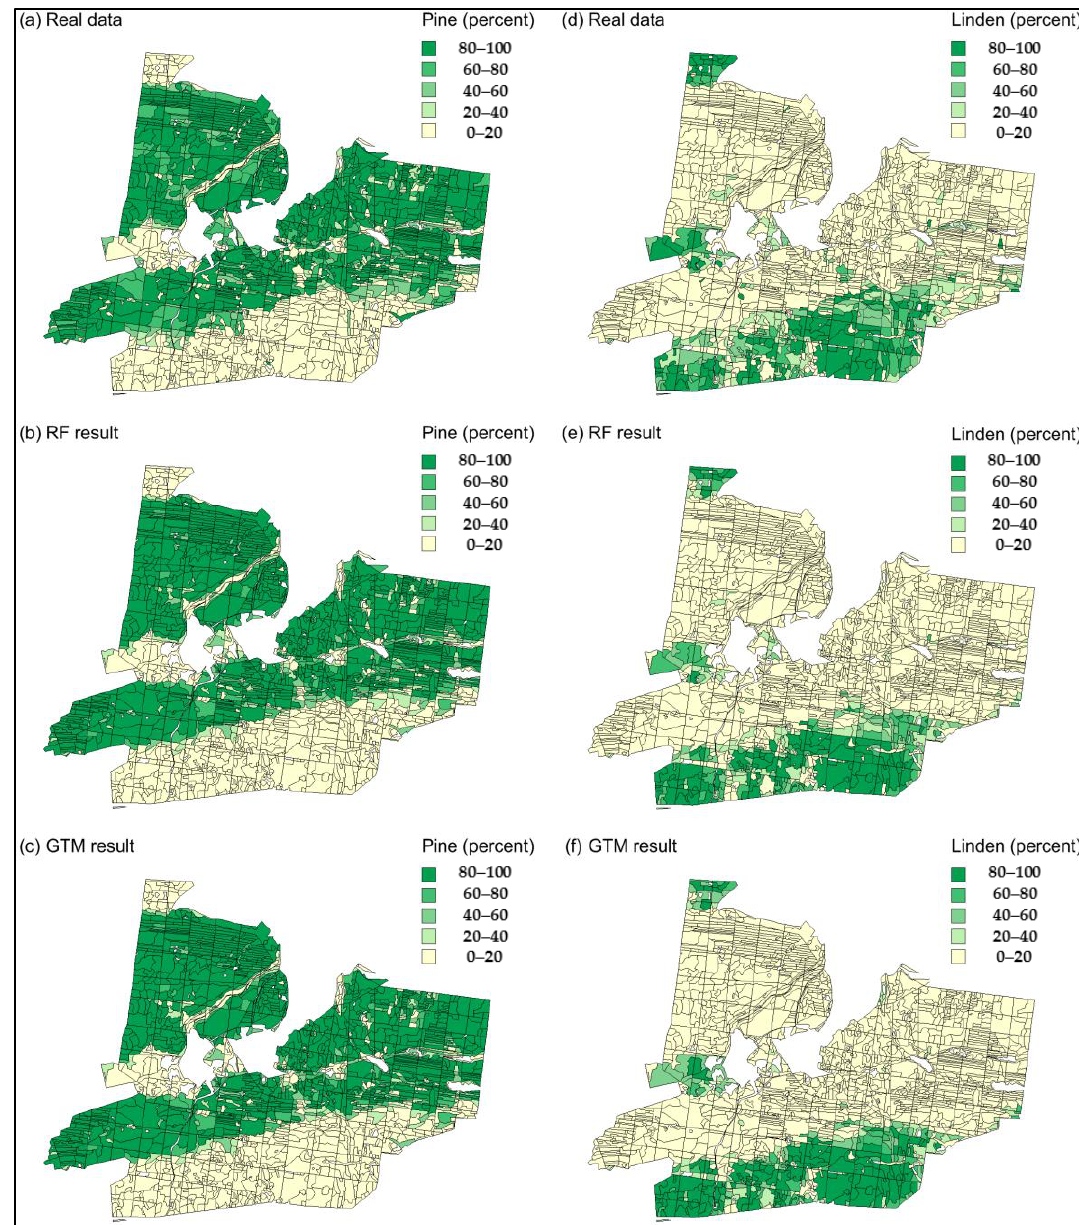
Figure 9. Thematic maps of the spatial distribution of real (according to ground inventory data) and predicted (according to models based on remote sensing Sentinel-2 data) percent abundance values of tree species in stands in Raifa forest: ( a ) pine, real data; ( b ) pine, RF model; ( c ) pine, GTM model; ( d ) linden, real data; ( e ) linden, RF model; ( f ) linden, GTM Table 6. Comparison of real and model percent abundance values of tree species in stands.